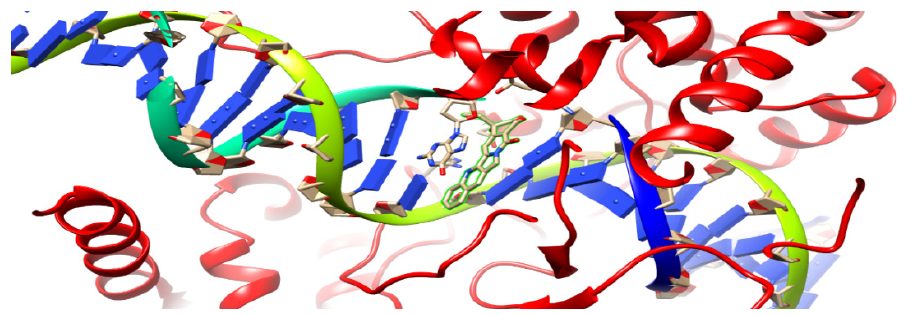
Figure 4. Ribbon diagram of 1t8i crystal structure; the highlighted part demonstrates acridine connected to a single DNA